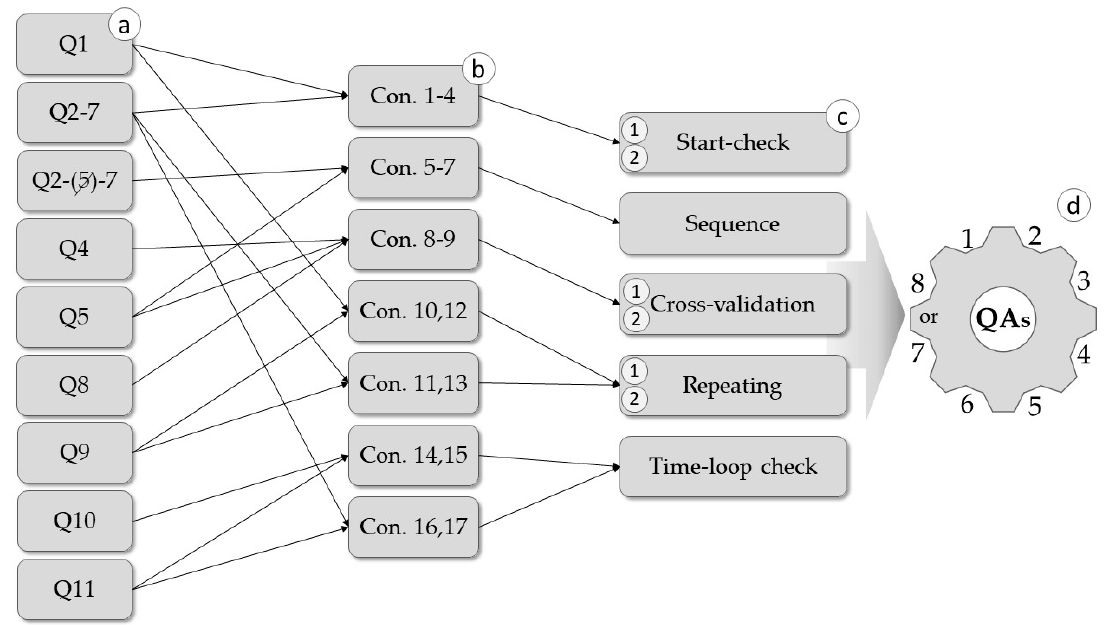
Figure 2. The four-tier structure of the data quality assurance (QA) framework: ( a ) set of logically related questions with number-coded answers, ( b ) conditional statements being the primary logical-based formula, ( c ) combination of several conditional statements creating a QA mechanism tier, and ( d ) combining mechanisms creating an advanced QA system. Table 1. Conditional (Con.) statements, the basis of the quality assurance (QA)